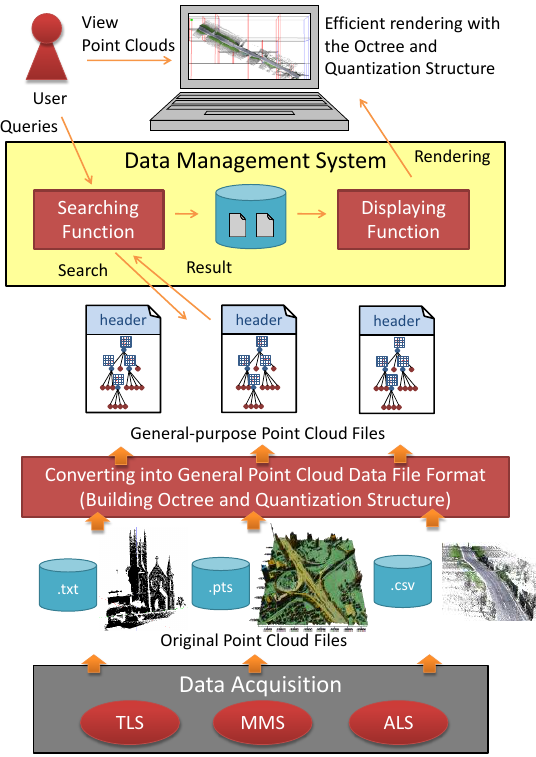
Figure 1. Overview of proposed data management